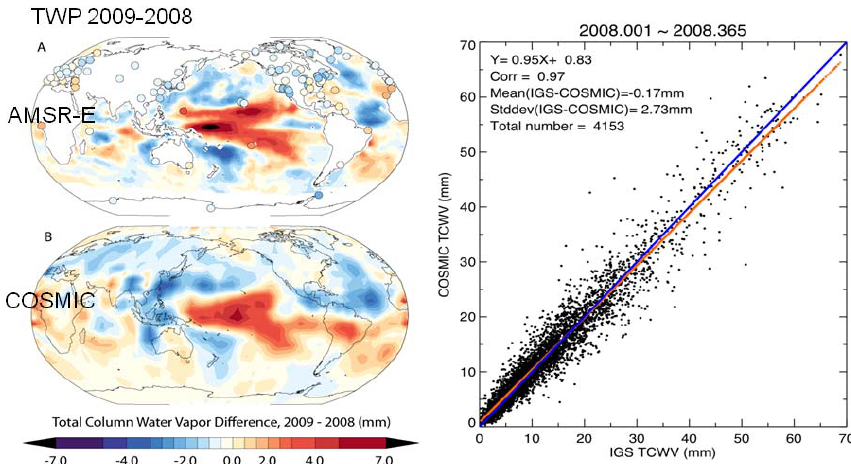
Fig. 36. Left: differences in precipitable water derived from AMSR-E and COSMIC soundings from 2008 to 2009. Warm colors indicate 2009 was wetter than 2008; cool colors indicate 2009 was drier than 2008 (Mears et al., 2010). Right: correlation of precipitable water in